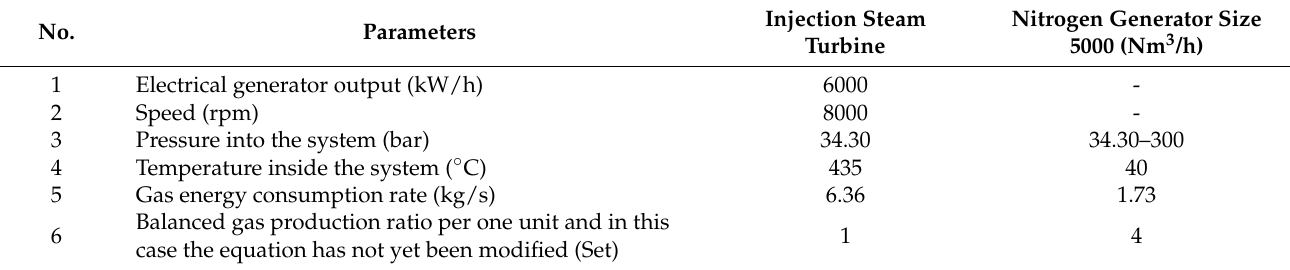
Table 6. Comparison of nitrogen generator (N 2 ) product model: PN-capacity-purity and injection steam turbine (steam) product model: